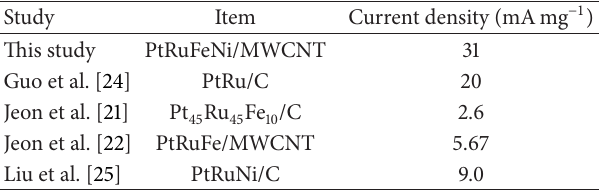
Table 4: Comparison of the current density with other